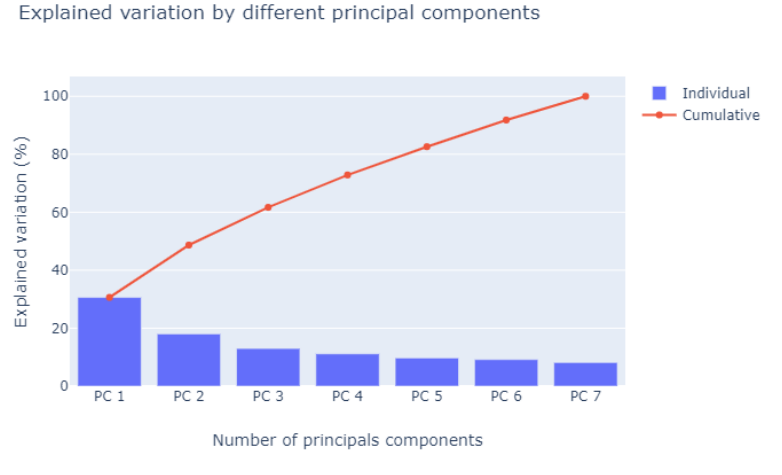
Figure 7. Variation explained by number of components used.